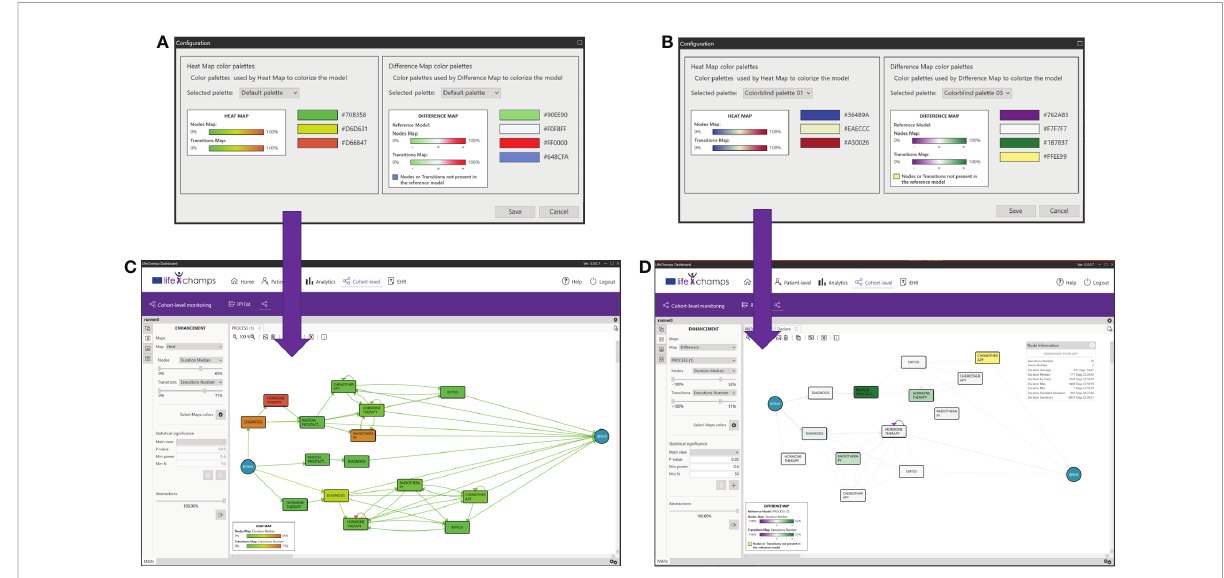
FIGURE 9 Enhancements. Color maps, palettes, and their application for enhancements. (A) Heat map colors, (B) heat map colors for colorblind, (C) enhanced model resulting from palette A, and (D) difference model resulting from palette